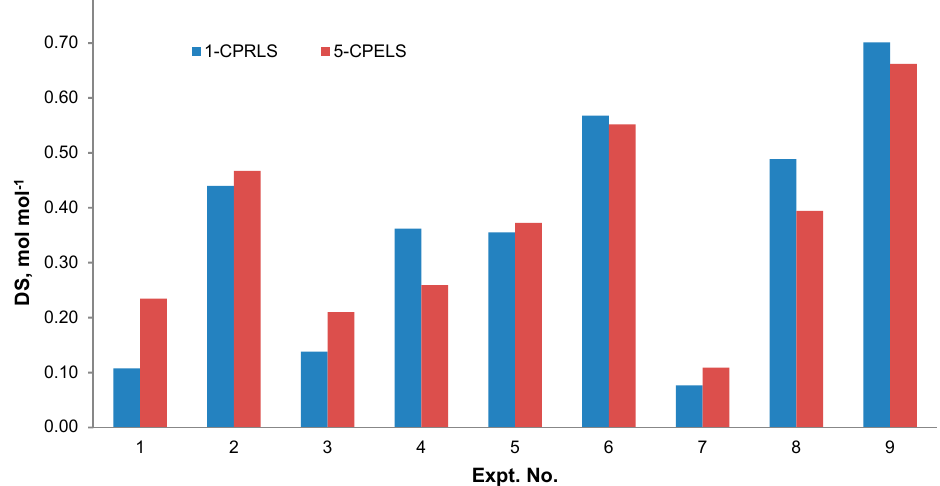
Figure 5. Degree of substitution (DS) for different samples produced under various reaction conditions stated in Table 2 for the production of 1-CPRLS and 5-CPELS.